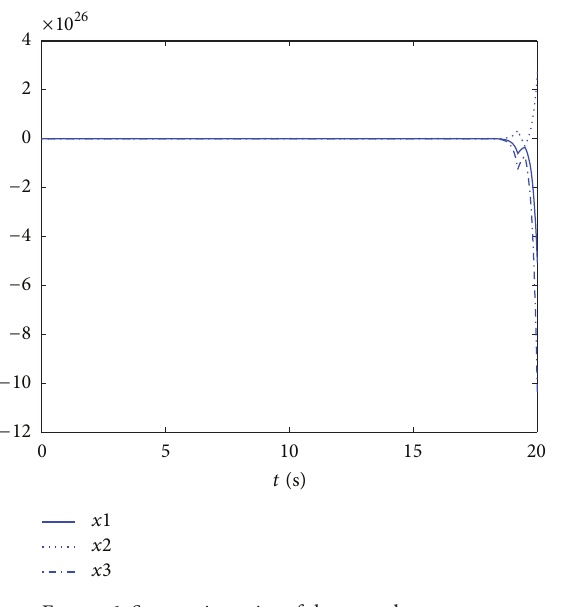
Figure 1: State trajectories of the open-loop system.